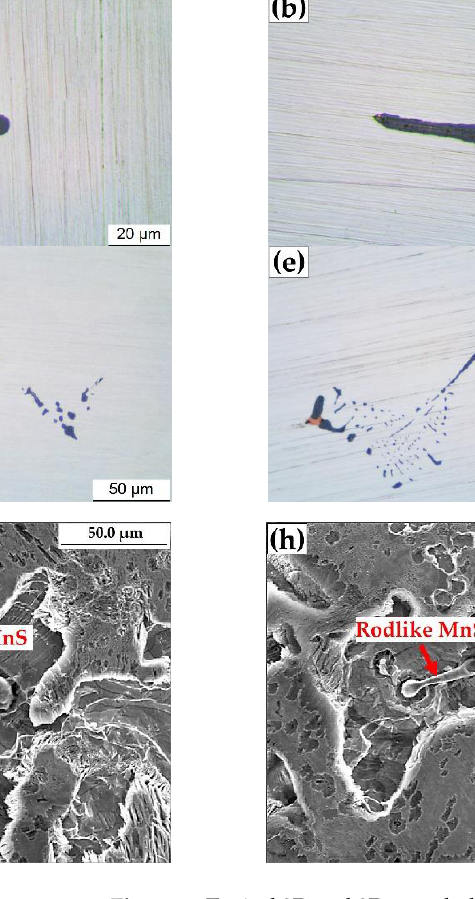
Figure 3. Typical 2D and 3D morphologies of MnS inclusions in the slab of medium carbon structural steel 45#. ( a – f ) 2D morphologies, ( g – i ) 3D morphologies.